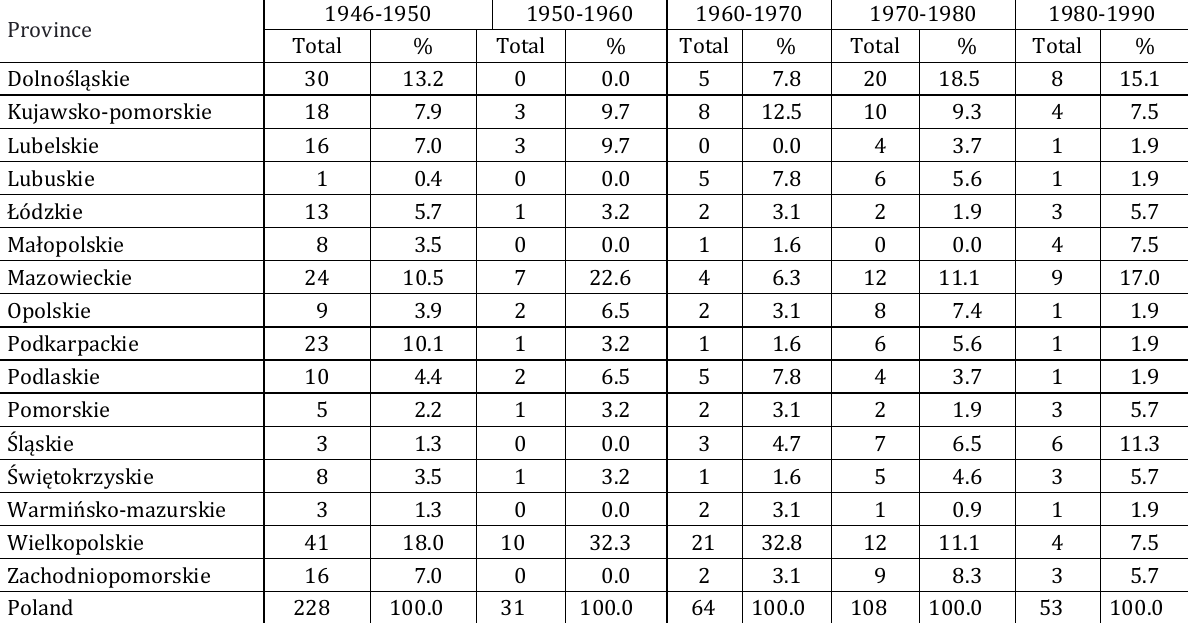
Table 1. Number and share of towns in the contemporary Poland that noted population decrease, 1946-1990, according to the administrative division of 2014 (by author on the basis of Annex 2: Kantor-Pietraga, 2014) Province